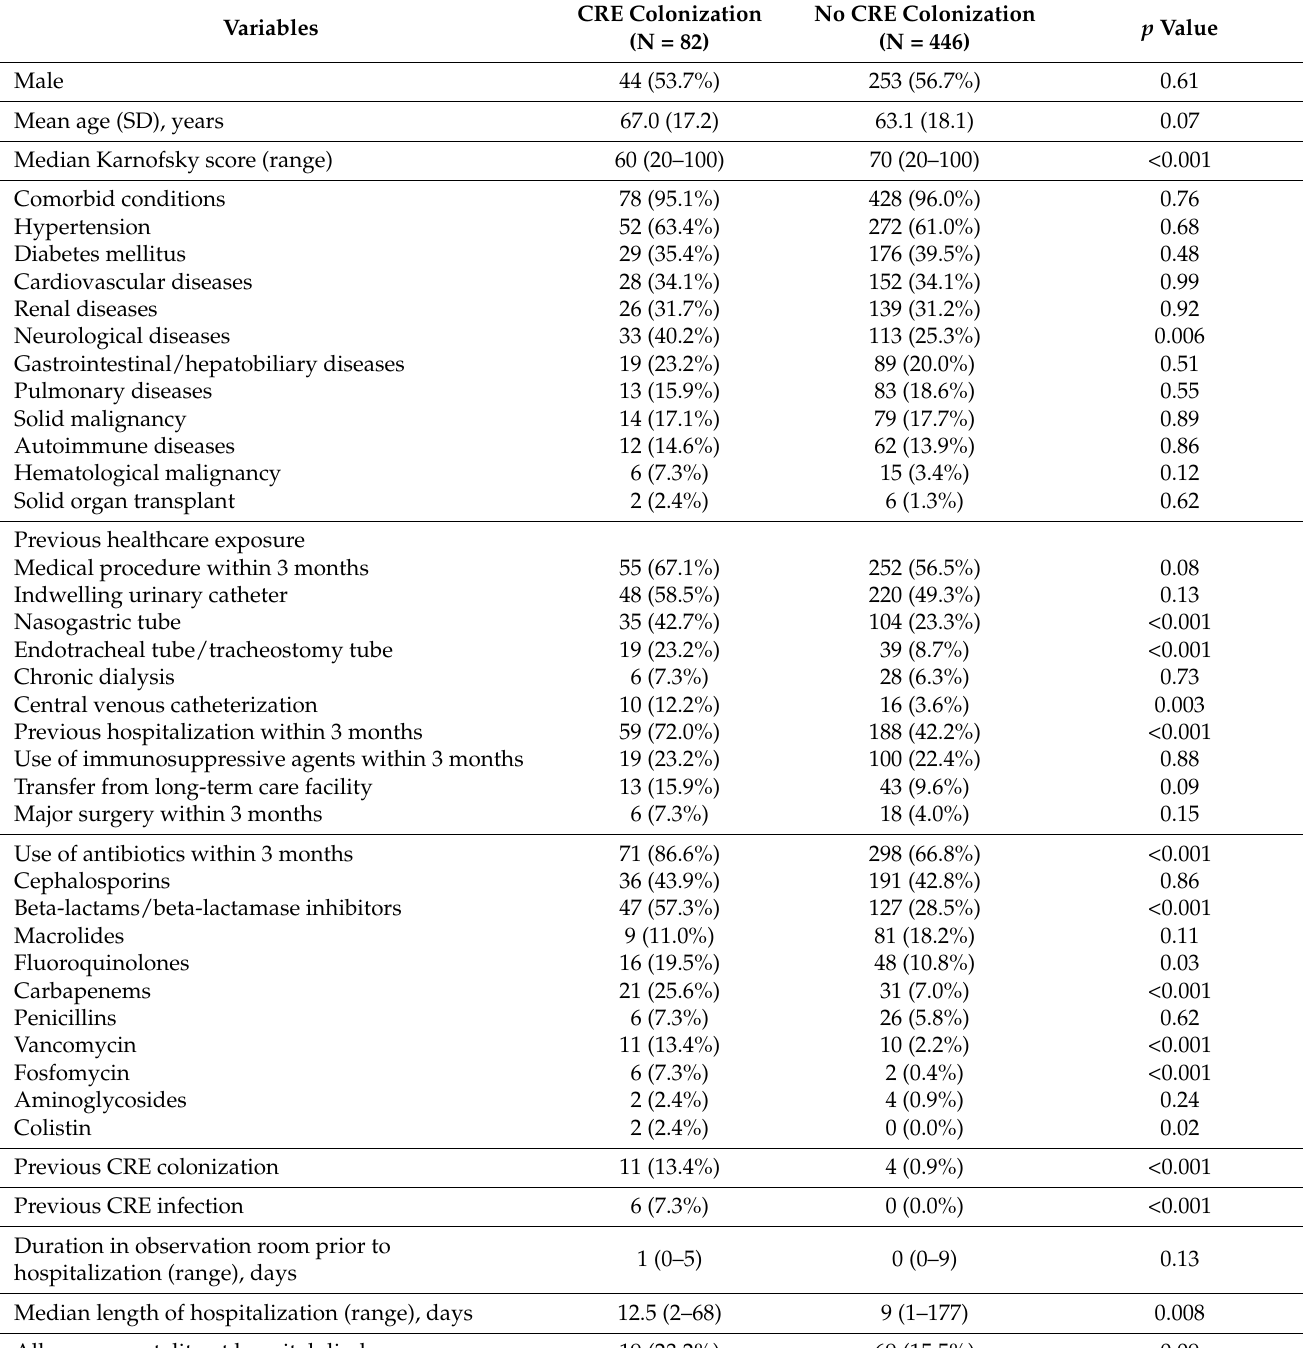
Table 1. Comparison of 528 patients with and without CRE colonization on